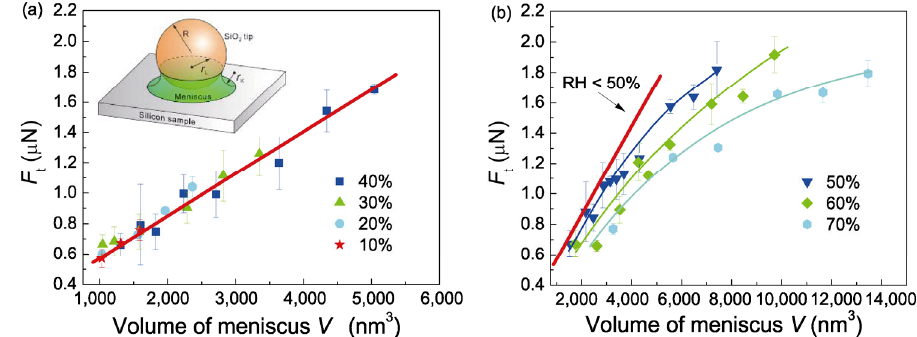
Fig. 8 Friction force vs. V at single-asperity contact interface of SiO 2 /Si pairs with (a) RH < 50% and (b) RH ≥ 50%. Inset (a): schematic of meniscus condensed at a single-asperity contact interface under humid conditions. Reproduced with permission from Ref. [38], © American Physical Society 2016. Thick red line in (b) is the same trend line found when RH < 50% in (a). Reproduced with permission from Ref. [98], © American Chemical Society